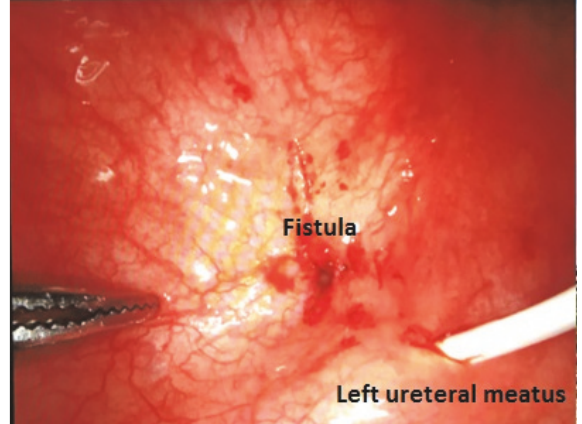
Figure 3: Fistula identification: in the transperitoneal view infratrigonal fistula is identified above the ureteral